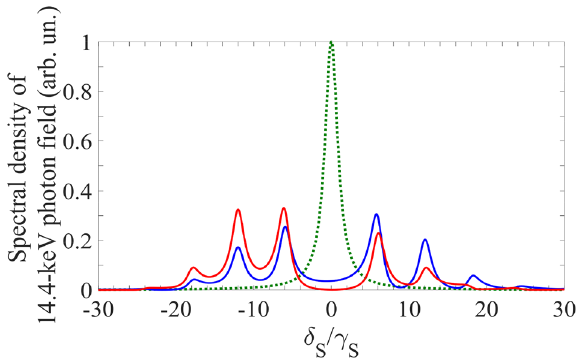
Figure 2. (Color online) Spectrum of an incident photon and the absorption spectral profile of the nuclear transition in the case of harmonically vibrating absorber under the AIT condition (Eq. 7). Green dotted curve is the spectral profile of the incident field in the case of Lorentz source’s spectral line with halfwidth γ S [the normalized modulus squared of Eq. (18)] in the laboratory reference frame. In the reference frame of the vibrating absorber, the green dotted curve turns into a blue (at ϑ plotted according to Eqs. (6) and (18) as